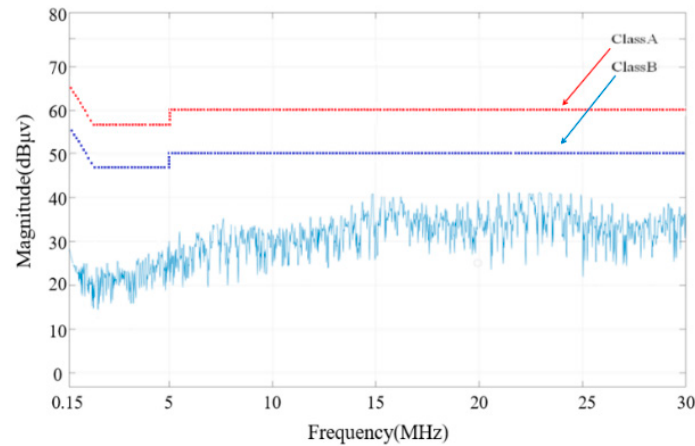
Figure 20. Simulation diagram of CM EMI with two-stage EMI filter.